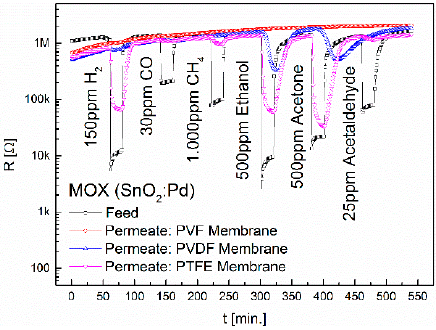
Sensors 2016 , 16 , 1605